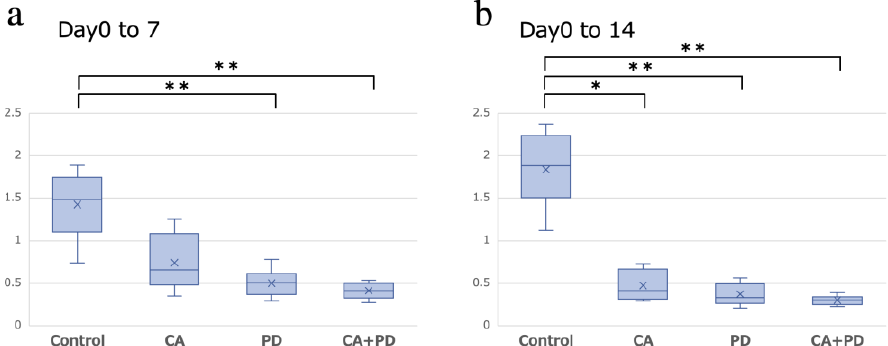
Figure 1. The volume change ratio of AT from day 0 to day 7 and from day 0 to day 14. ( a ) From day 0 to day 7, there were no significant differences between the Control and CA groups; however, there were significant differences between the Control and PD groups and between the Control and CA + PD groups (** p < 0.01). ( b ) From day 0 to day 14, there was a significant difference between the Control group and the other three groups (* p < 0.05, ** p < 0.01); however, we found no significant difference between the CA and anti-PD-1 antibody treatment groups.